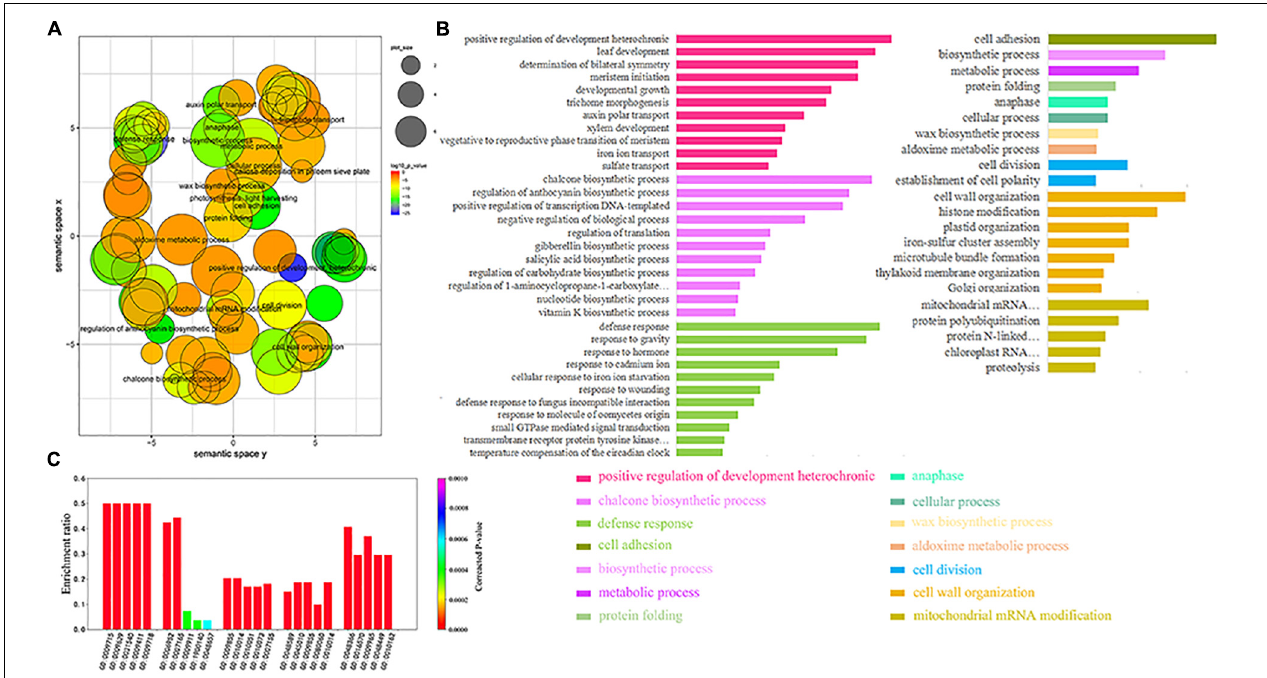
FIGURE 5 | Gene ontology (GO) analysis of soybean MTRMs. (A) Semantic relevance of GO terms wherein the GO pathway has a certain concentration. (B) GO annotation enriched with 483 soybean MTRMs with enrichment results, which mainly involve positive regulation of development, heterochronic, chalcone biosynthesis, defense responses, and mitochondrial mRNA modification. (C) GO enrichment of the top five soybean MTRMs. The listed GO terms were enriched with significant p -values <